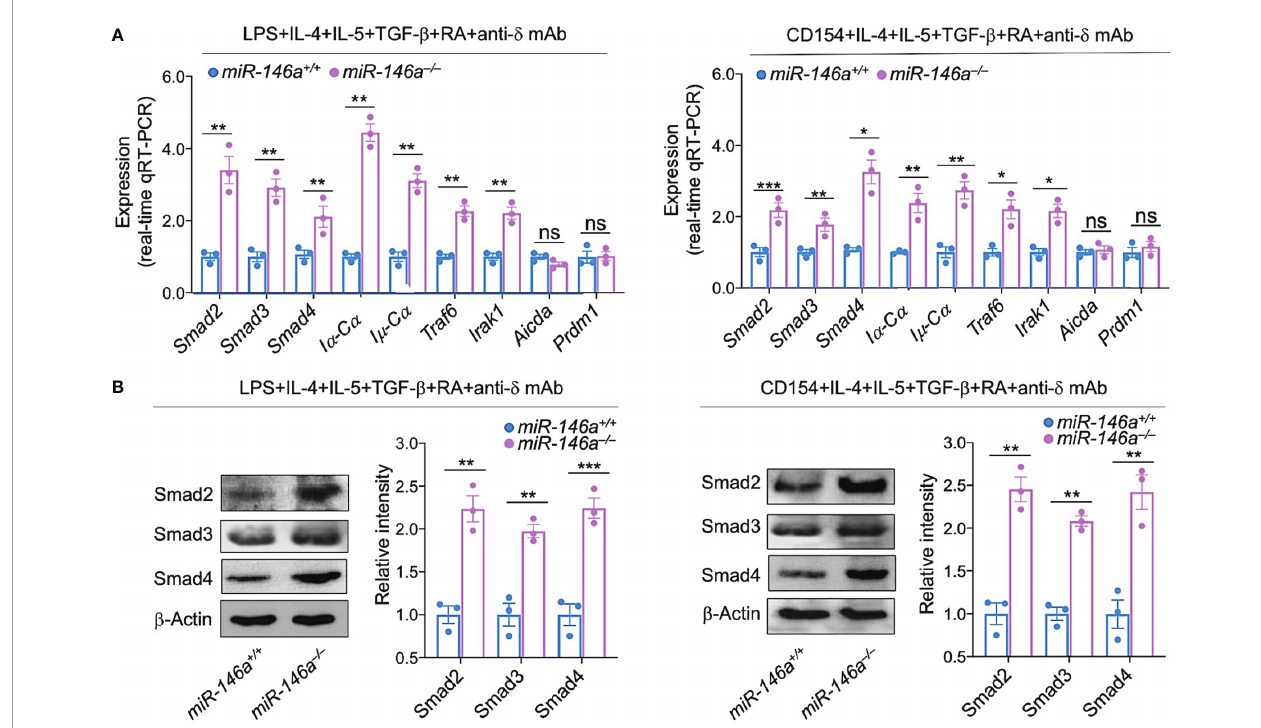
FIGURE 7 | miR-146a deletion increases expression of Smad2, Smad3 and Smad4 , germline I a -C a and post-recombination I m -C a transcripts. miR-146a – / – and miR-146a +/+ B cells were stimulated with LPS or CD154 plus IL-4, IL-5, TGF- b , RA and anti- d mAb, and cultured for 72 h. (A) The expression of Smad2 , Smad3 and Smad4 as well as I a -C a , I m -C a , Traf6, Irak1, Aicda and Prdm1 transcripts was analyzed by qRT-PCR performed in triplicate and normalized to b -Actin. (B) Expression of Smad2, Smad3 and Smad4 proteins as analyzed by immunoblotting. Densitometry quanti fi cation of immunoblotting signals was normalized to b -Actin levels and depicted as ratios of readings in miR-146a – / – and miR-146a +/+ B cells to the average value in miR-146a +/+ B cells. Data are ratios to stimulated miR-146a +/+ B cells (set as 1; means±SEM of three independent experiments). *** p < 0.001, ** p < 0.01, * p < 0.05, ns, not signi fi cant, unpaired t